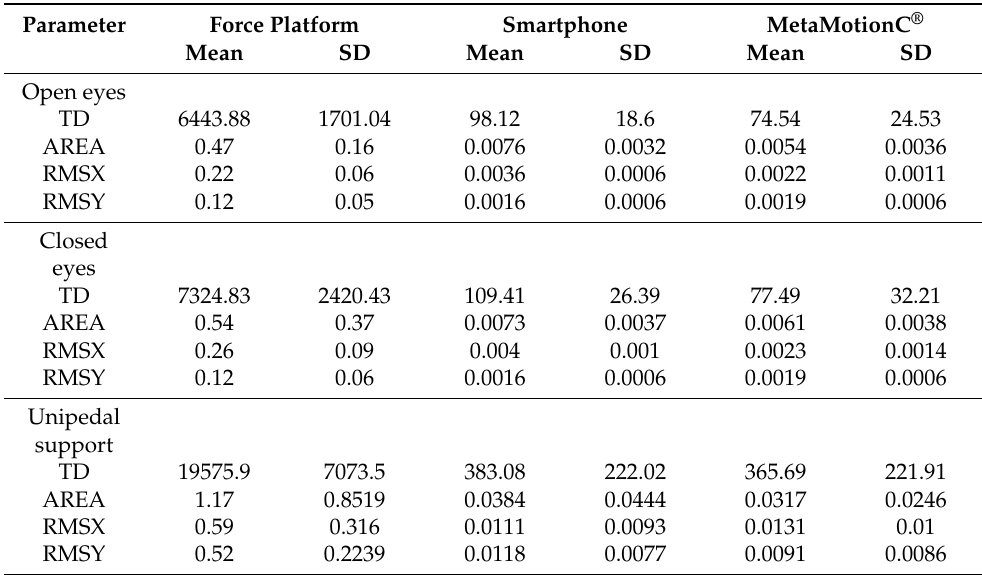
Table 2. Mean values of the stabilometric parameters estimated using the force platform and ac- celerometers in wearable and mobile devices.